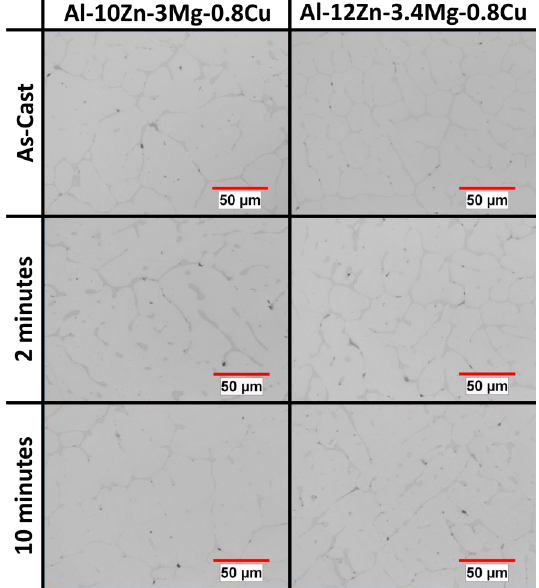
Figure 1. Microstructures of representative alloys in the as-cast condition, and after a solutionizing heat treatment of 2 and 10 min at 753.15 K (480 °C).